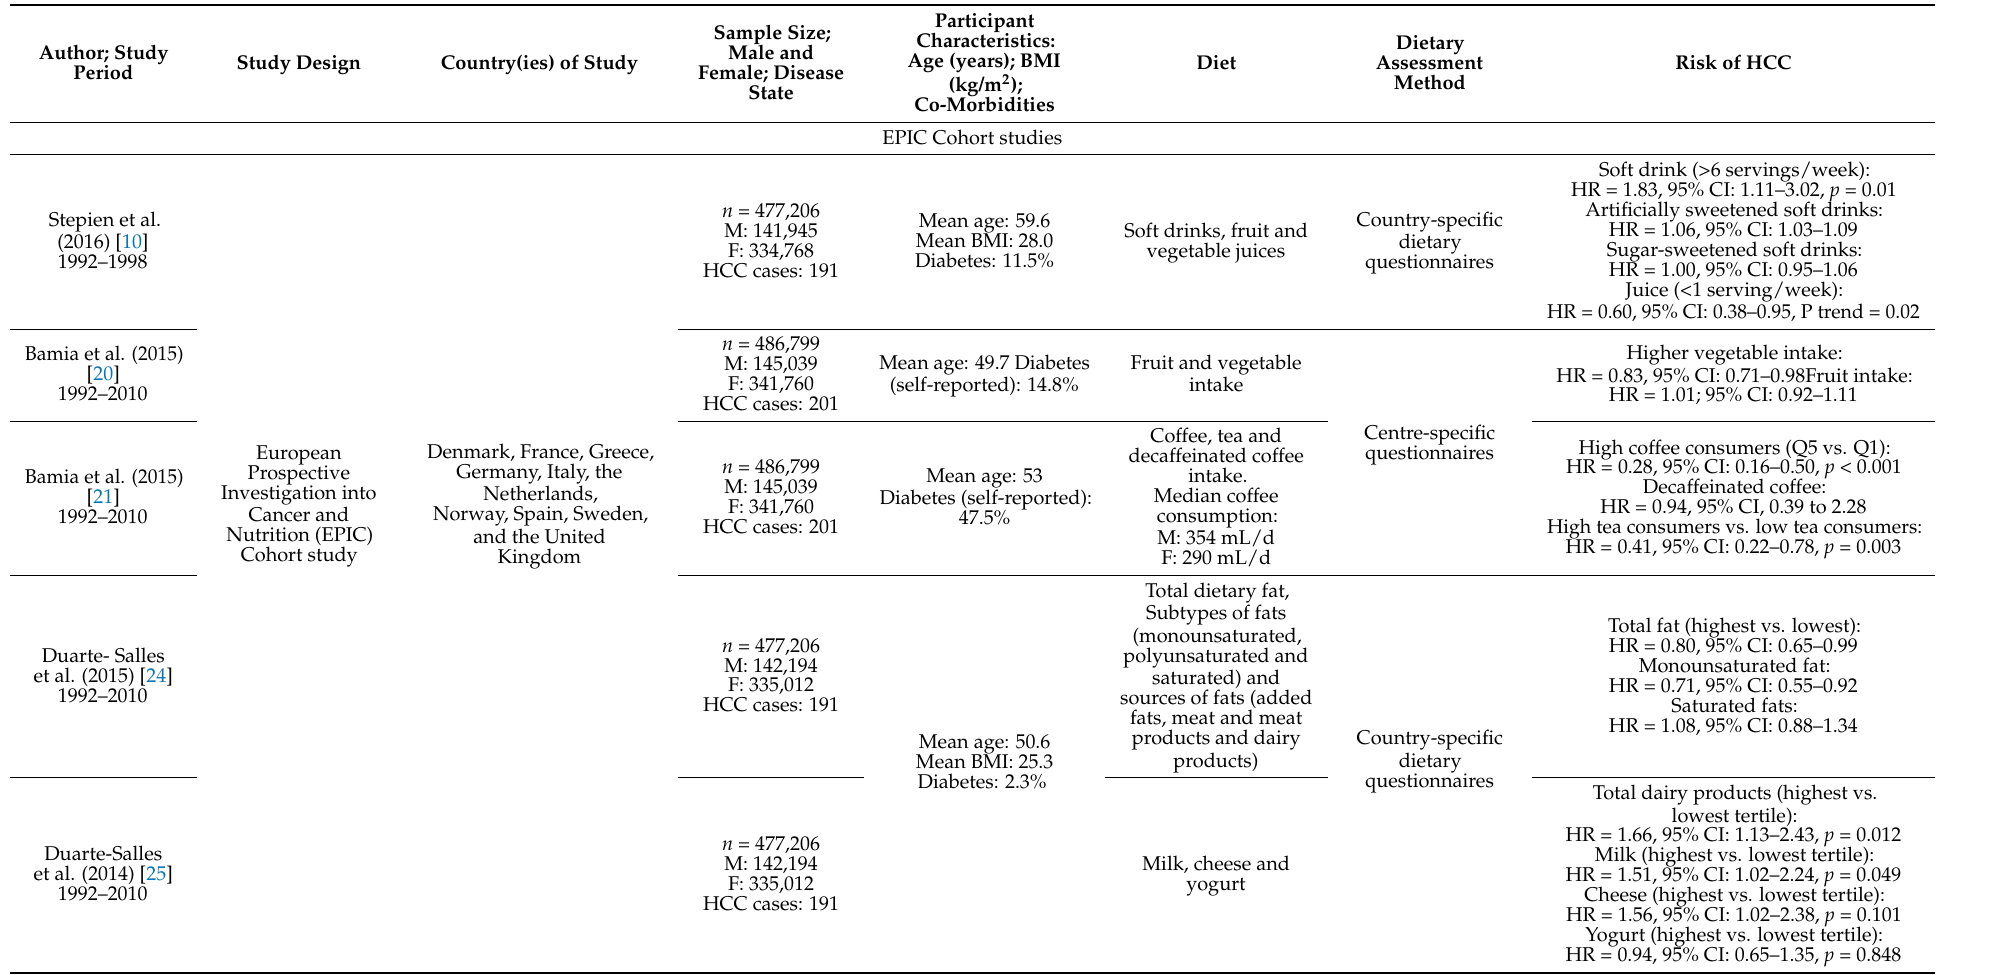
Table 3. Summary of studies ( n = 30) evaluating the association between diet and hepatocellular carcinoma